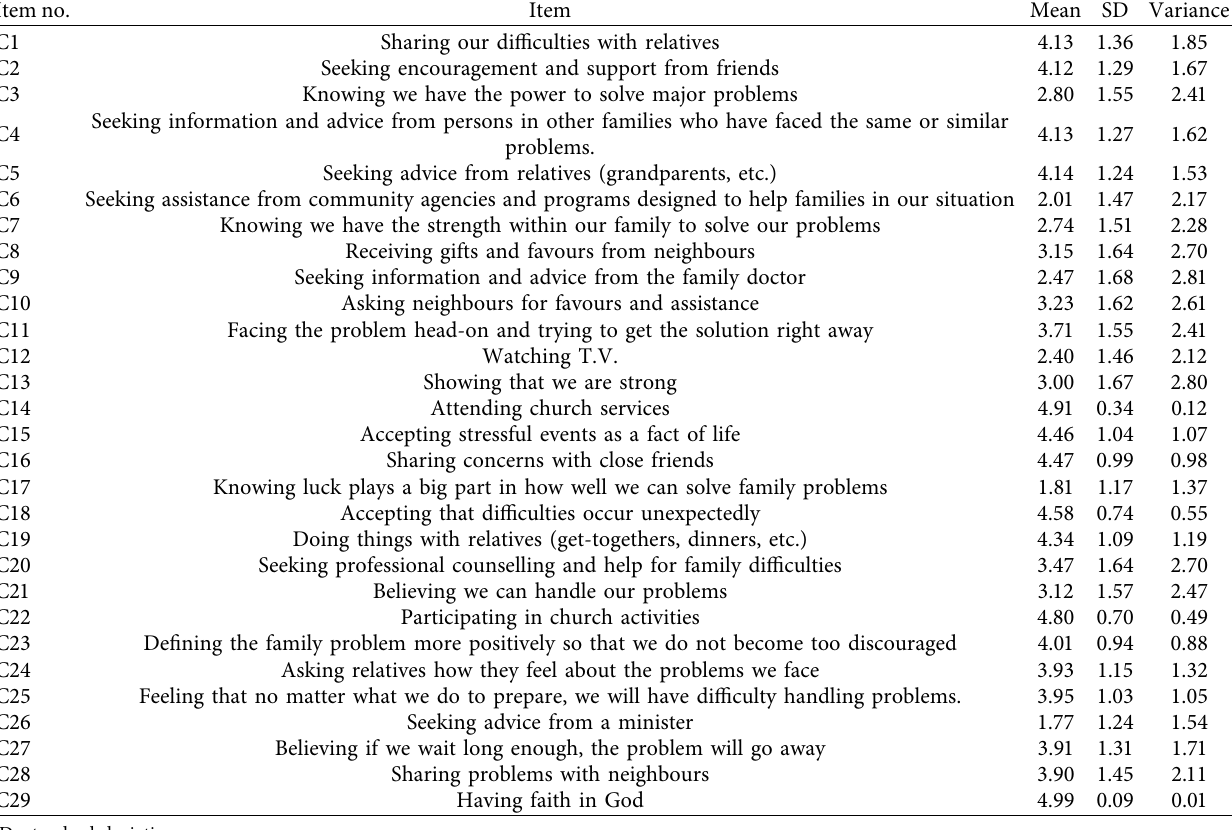
Table 4: Descriptive statistics of caregivers’ responses to the coping strategy questions ( n � 113). Item no.